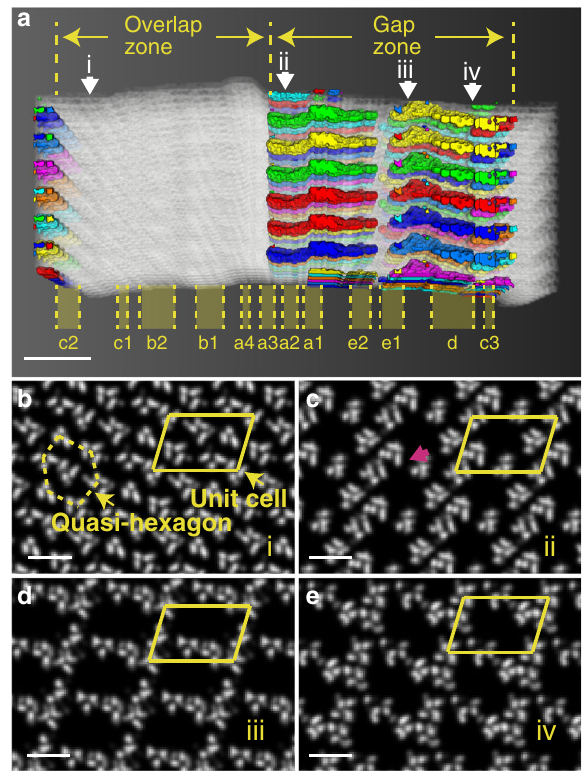
Fig. 3 Analysis of the 3D electron density map of the structure of collagen. The electron density map is created from X-ray diffraction data 32 . a Intermolecular voids within the collagen structure, with the gap/overlap zones and the banding structure labeled. The white structures correspond to the collagen molecules, and the channels between them are labeled with different colors based on their connectivity. b – e Cross-section slices viewed along the collagen fi bril cut at position i (0.075 D), ii (0.505 D), iii (0.773 D) and iv (0.872 D) as highlighted by white arrows in a , respectively. b Shows the typical structures of overlap region, while c – e show the 2 – 3 nm wide channels in gap region with varying cross section shapes. The unit cell is highlighted by the yellow parallelogram. A ~0.3 nm wide small connection is highlighted by magenta arrow in c . Scale bars: a 2 nm, b – e 10